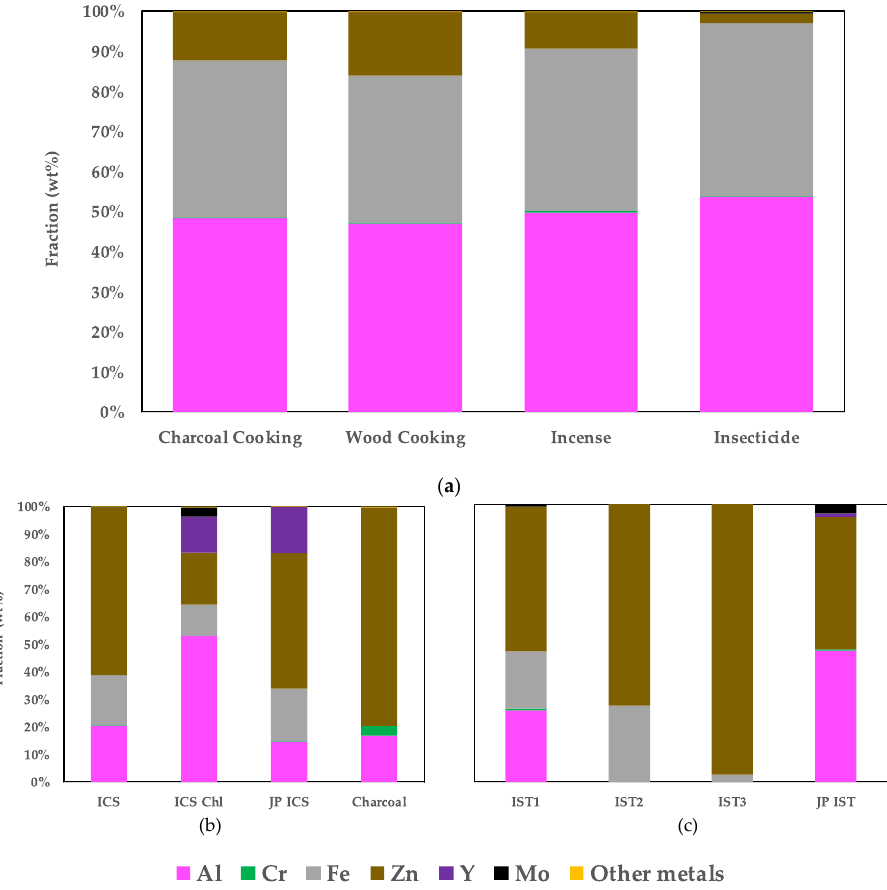
Figure 6. Average fraction of the major metallic elements in different particulate matter samples ( a ) collected by in situ samplings, ( b ) ICS collected by laboratory samplings, and ( c ) IST collected by laboratory samplings. Mali ICS: incense used in Mali; Mali ICS & Chl: incense used in Mali mixed with Charcoal; Japan ICS: incense used in Japan; Mali ICS 1, 2 and 3: insecticide used in Mali (different brands); Japan IST: insecticide used in Japan.